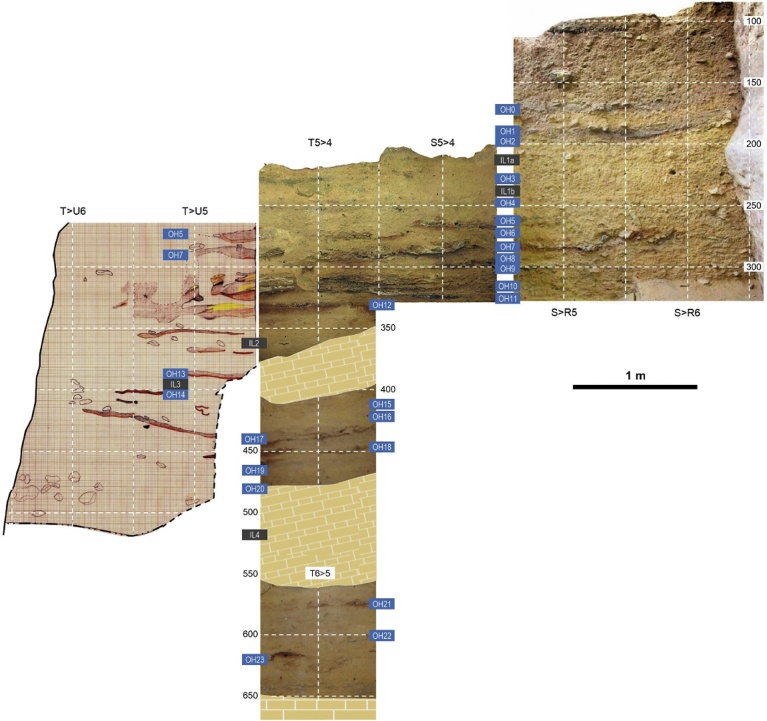
La Boja. The archeo-stratigraphic sequence. Trench cross-sections as recorded at the end of the 2013 field season (for an extended discussion, see the SI appendix). Elevations are in cm below datum.